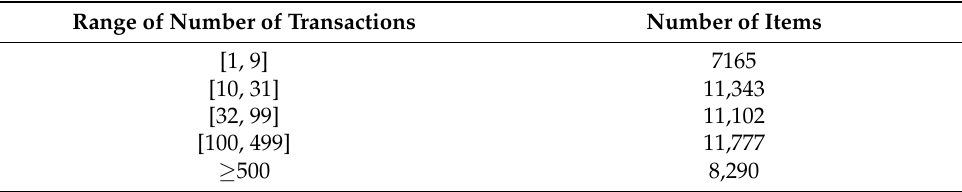
Table 2. The number of items depending on the range of number of transactions.